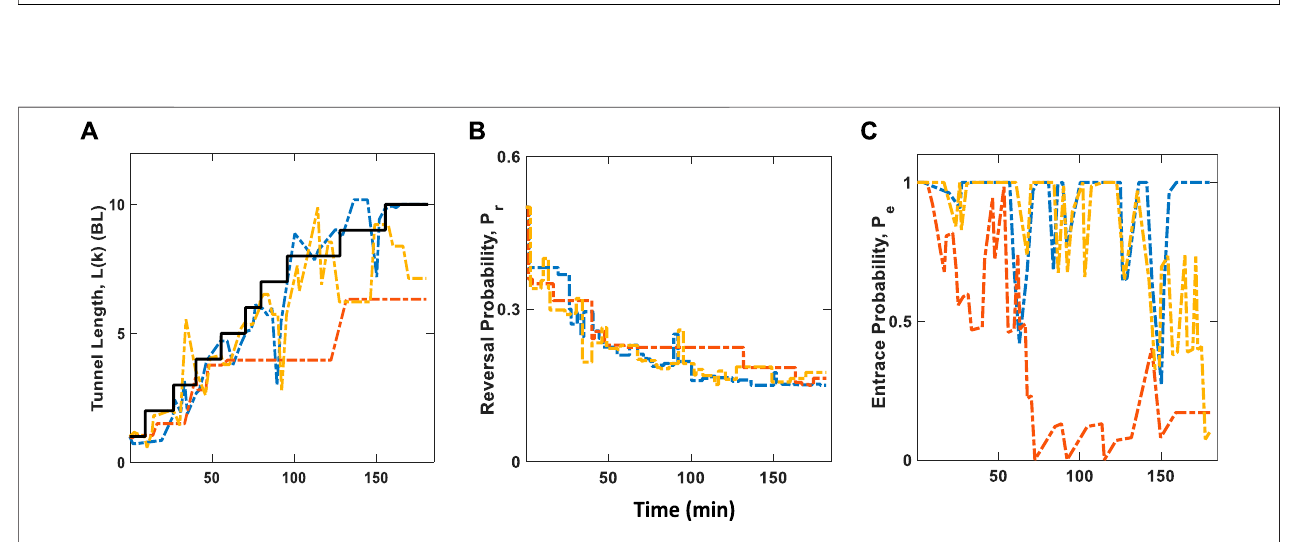
FIGURE 5 | Estimated tunnel length, L ( k ), Reversal probability, P r , and Entrance probability, P e over time for individual robots based on Adaptive rule. Dashed colored lines represent robot A (red), robot B (blue), and robot C (yellow). Solid black line represents actual tunnel length measurement (A) Plot shows how individual robotstracktheactualgrowingtunnel,basedondead-reckoningmethodandexponentialmovingaverageformuladescribedin Eq.3.(B) Reversalprobabilityvaluesfor individualrobotsasafunctionoftime.Thesecurvescloselymatchthecurvedescribedin Figure3B(C) Plotoftheentranceprobabilityvaluesovertime.Thisshows how robots initially started off with equal digging “ desires ” and gradually become unequal “ desires ” as the tunnel length grows.